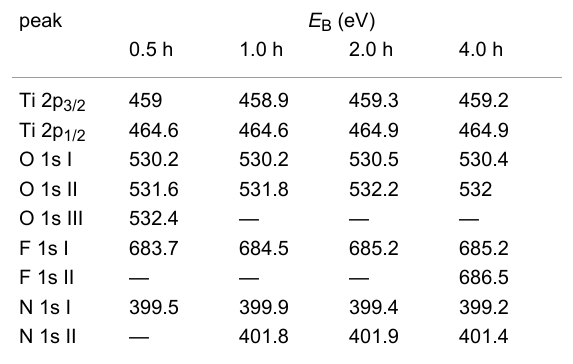
Table 1: Binding energy ( E B ) values for the peaks of the high-resolu- tion XPS spectra.